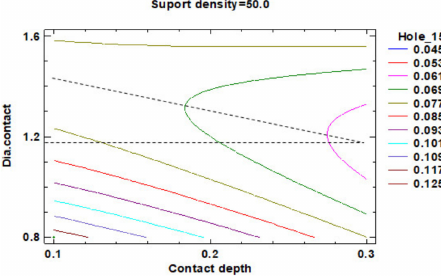
Figure 32. Contours of Estimated Response Surface for Roundness Hole_15 and centre contact depth.